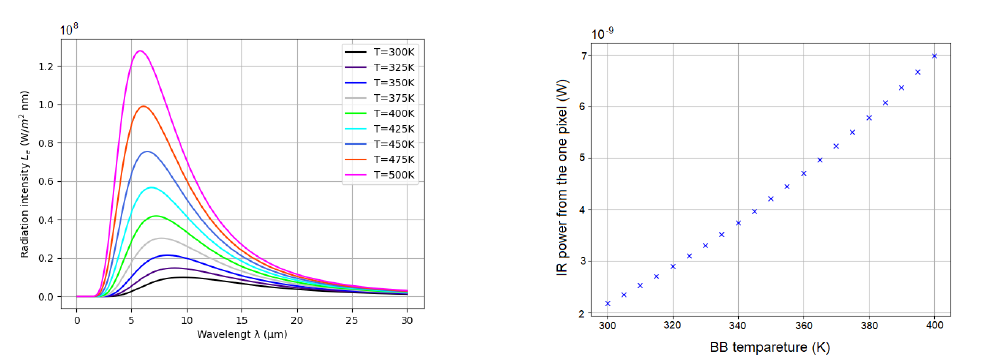
Figure 2. Radiant spectral exitance of BB temperatures from 300 to 500 K. ( Left ): relationship between the BB radiant spectral exitance and the wavelength. ( Right ): relationship between the IR power impugned on one pixel sensitive area, located in the middle of the